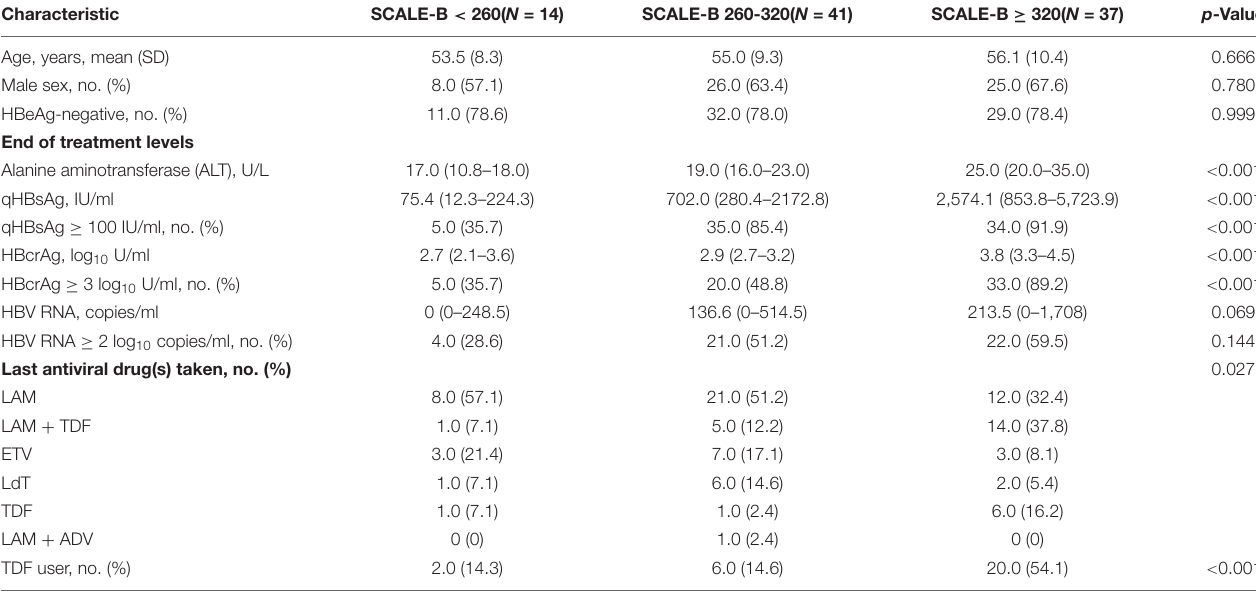
TABLE 1 | Baseline clinical characteristics of the cohort stratified by SCALE-B scores ( n = 92).